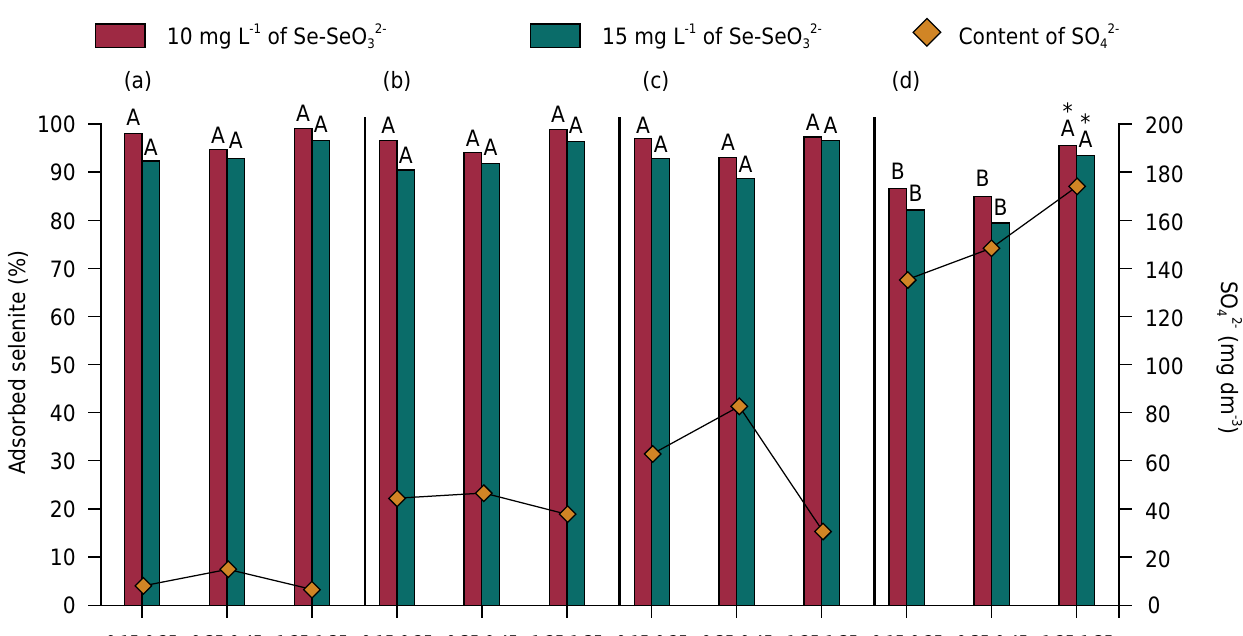
Figure 2. Selenite (SeO 32- ) adsorption ( %) at three soil layers of a Latossolo Vermelho distrófico (Oxisol). The letters (a), (b), (c), and (d) correspond respectively to the rates of phosphogypsum applied to the soil, as follows: 0, 7, 14, and 56 t ha -1 . The letters and the (*) above the bars compare the means by the Scott-Knott test at 95 % probability. The letters compare the adsorption of SeO 32- under the influence of different sulfate (SO 42- ) contents for the same soil layer. Bars with (*) indicate statistical differences in SeO 32- adsorption rates among soil depths within the same applied phosphogypsum